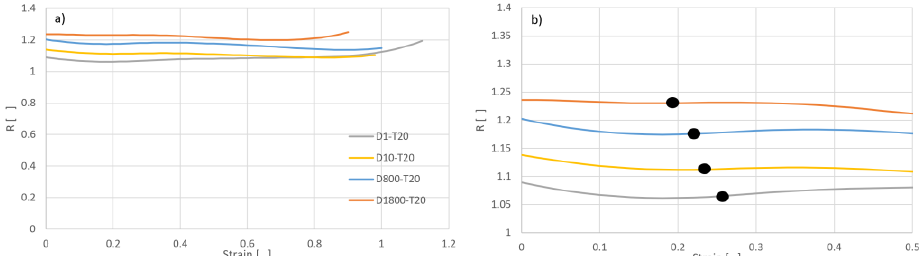
Fig. 6. Dynamic amplification function R vs strain for all the dynamic tests at room temperature (a) and magnification (b).